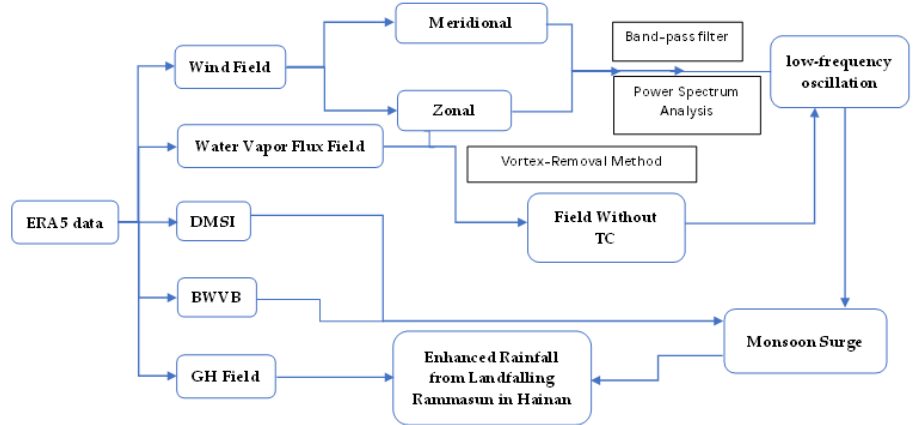
Figure 1. The flowchart of the methods used in this study.